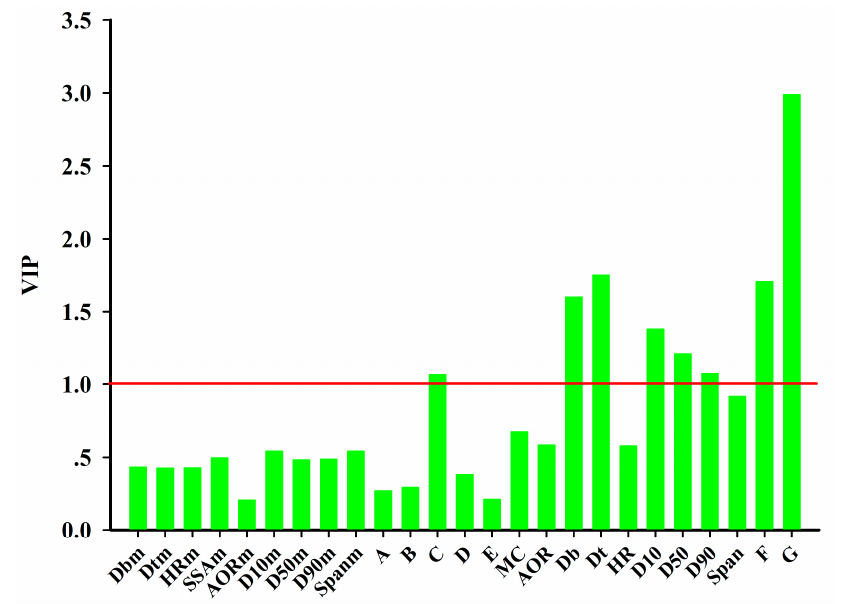
Figure 11. Variable importance in the projection (VIP) indexes of each variable in the MBPLSPM. A–F refers to pre-mixing time, impeller rate, binder amount, liquid additive rate, granulation time, lubrication time and minimal punch tip separation distance, respectively.